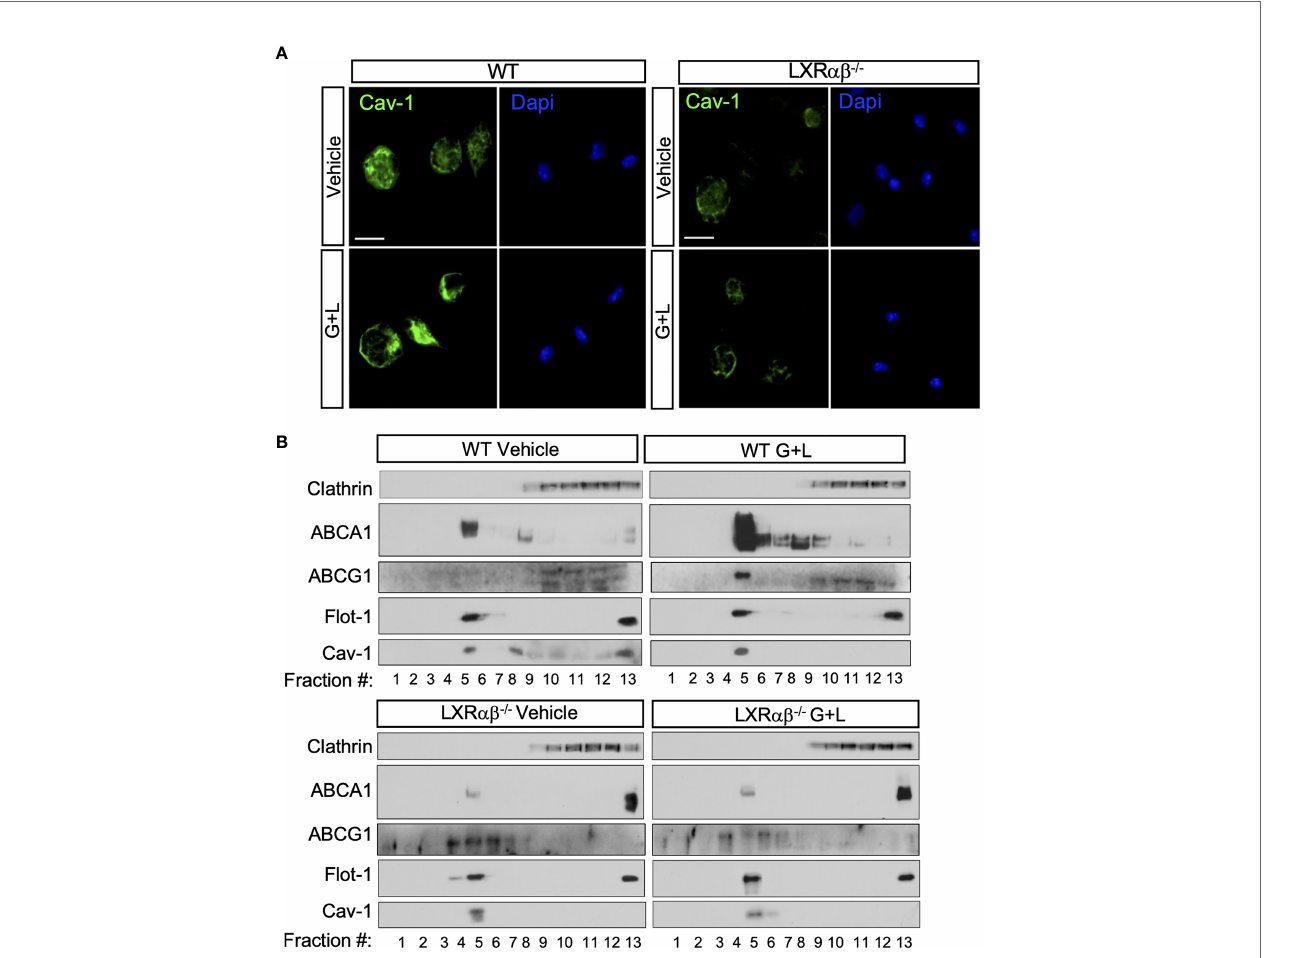
FIGURE 3 | Cav-1 cellular distribution is dependent on LXR. (A) Representative images showing the subcellular distribution of Cav-1 (green) by confocal microscopy in peritoneal macrophages from WT and LXR ab -/- mice treated for 24 h with 1 m M GW3965 and 100 nM LG268 (G+L). Nuclei were stained with DAPI. Experiment was performed 3 independent times. Scalebar: 10µm. (B) Representative Western blot analysis of Cav-1 and ABCA1 and ABCG1 in lipid raft fractions from WT and LXR ab -/- peritoneal macrophages treated for 24 h with